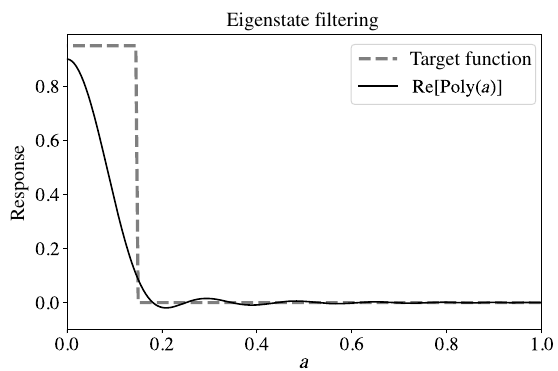
FIG. 29. The response function for the polynomial approxi- mation to the eigenstate filtering function with δ = 0.3 and d =